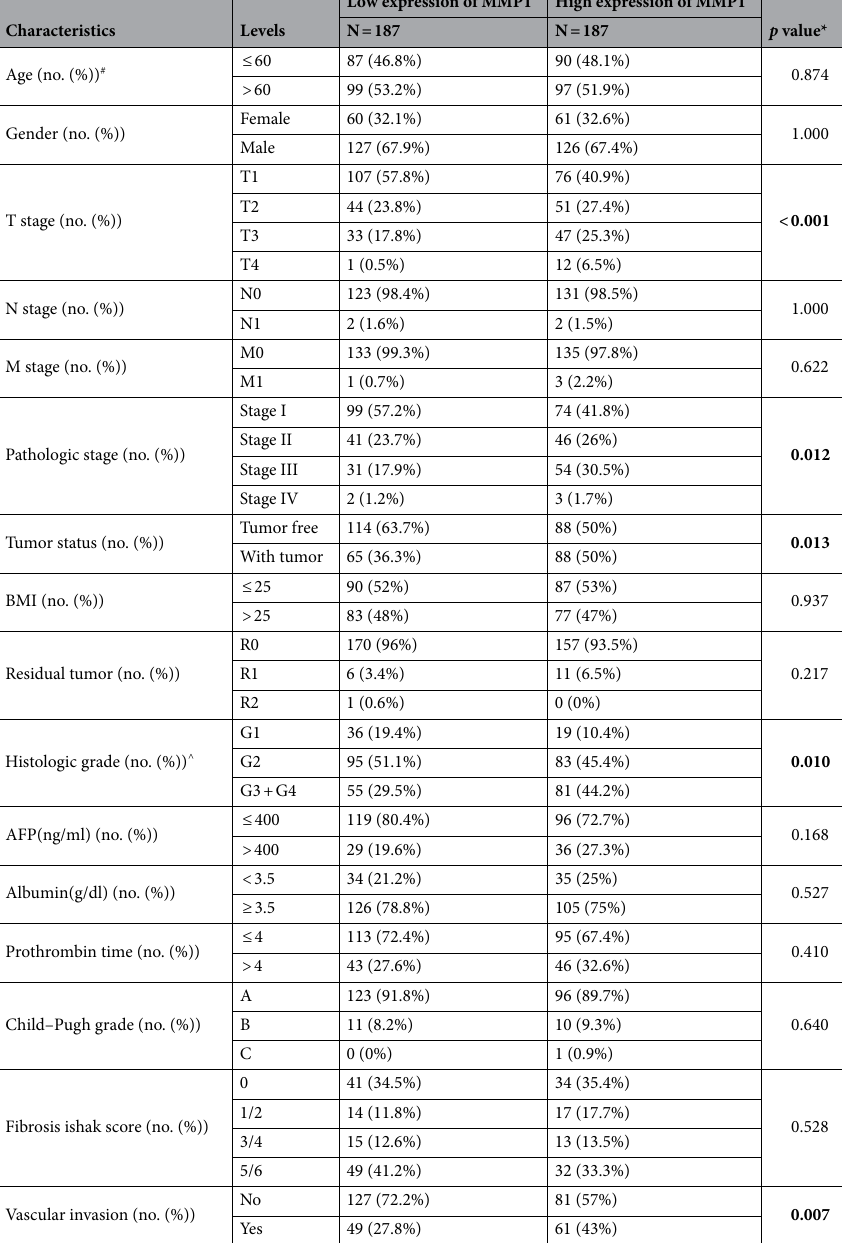
Table 1. Baseline characteristics of patients (TCGA-LIHC). Data are presented as n (%). *Compared with each group (Fisher exact test, or Pearson’s chi-square test). #Compared with Wilcoxon rank sum test. ^Compared with Kruskal–wallis Test. p value < 0.05 was considered statistically significant (highlighted in